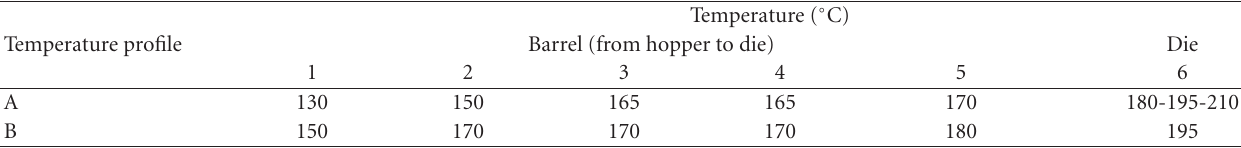
Table 11: Temperature profiles for PLA chemical foaming through single-screw extrusion.